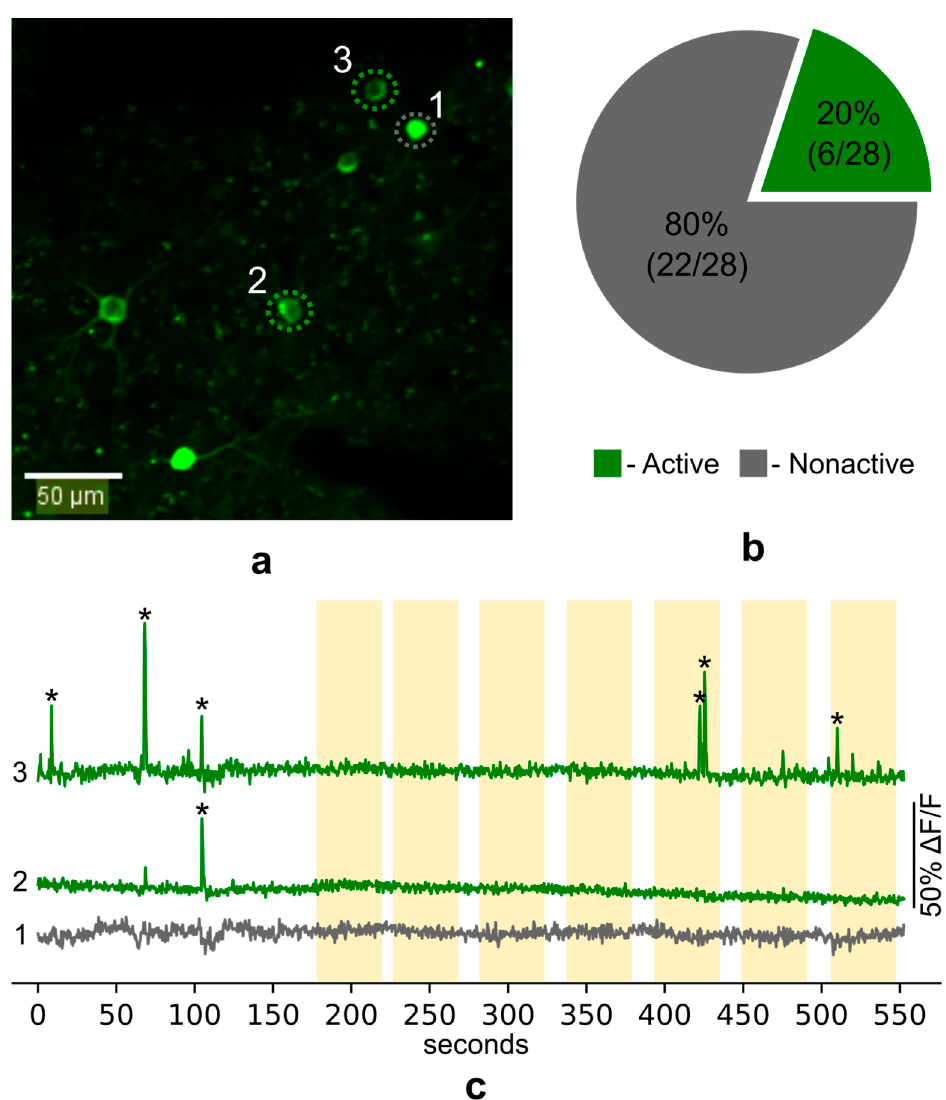
Figure 7. ( a ) Example field of view during in vivo imaging of Fos-Cre-GCaMP neurons; green-colored ROI—example of active cells, grey-colored ROI—example of nonactive cells. ( b ) Percentage of active and silent neurons ( n = 3 mice). ( c ) Example calcium traces of Fos-TRAPed PtA neurons during presentation of the auditory CS. Asterisks * mark calcium events.